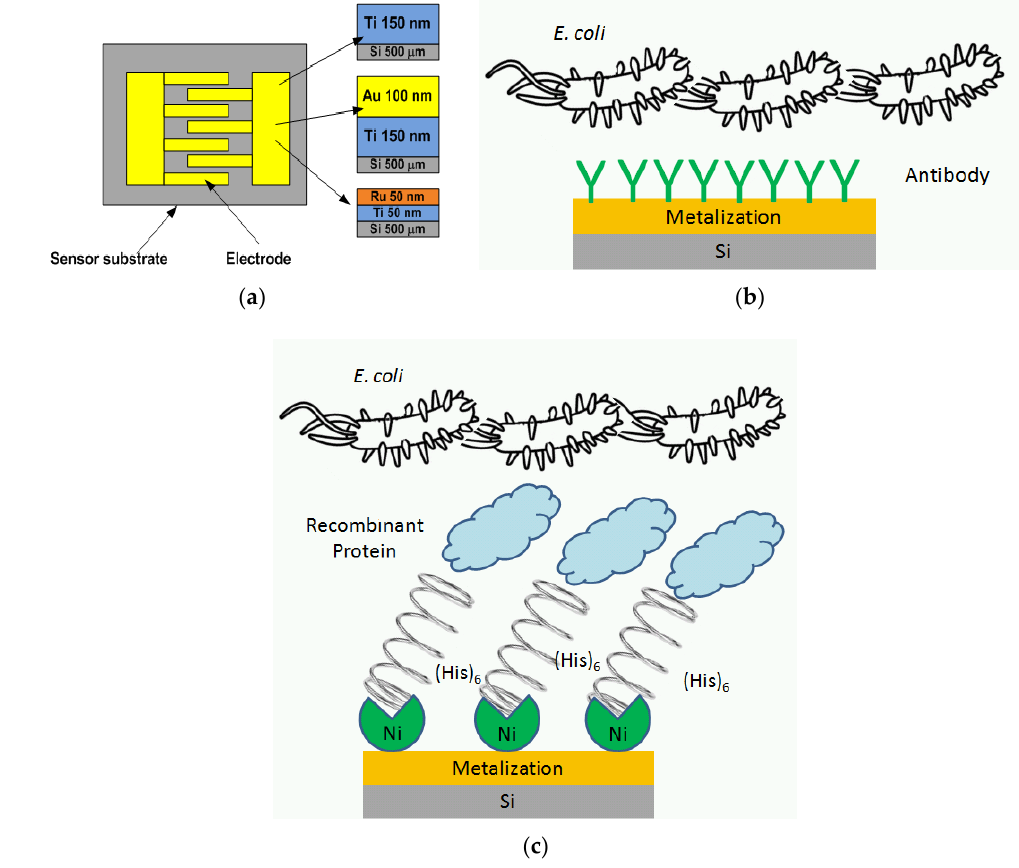
Figure 2. ( a ) Schematic image of the proposed sensors with investigated Ti, Au, Ru metallizations. Schematics of the biofunctionalization procedures: ( b ) using 3-aminopropyltriethoxysilane (APTES)